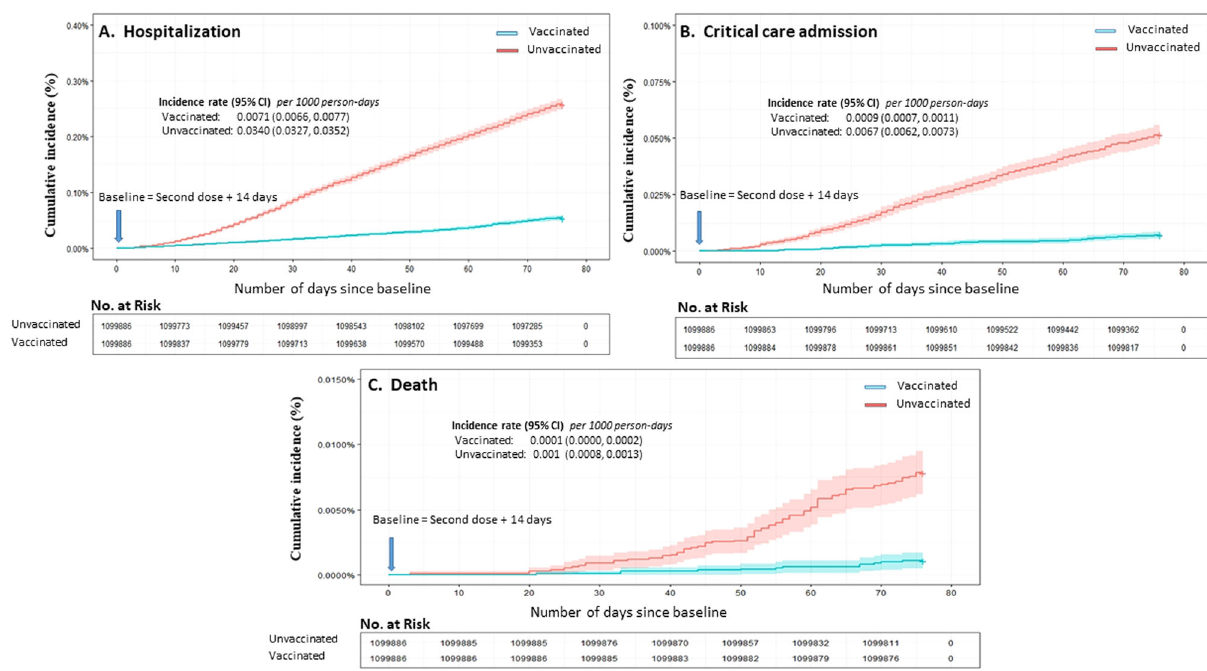
Fig. 2 Cumulative incidence of severe outcomes of COVID-19. The blue curve represents vaccinated subjects and the red curve represents unvaccinated individuals. The error bands represent the 95% con fi dence intervals. The No. at Risk table in each plot represents the number of participants at risk for the outcome at given follow-up times. A The cumulative incidence curve of hospitalization. B The cumulative incidence curve of critical care admission. C The cumulative incidence curve of death. Table 2 Effectiveness of the Vaccine in Preventing Severe COVID-19 Outcomes strati fi ed according to different risk